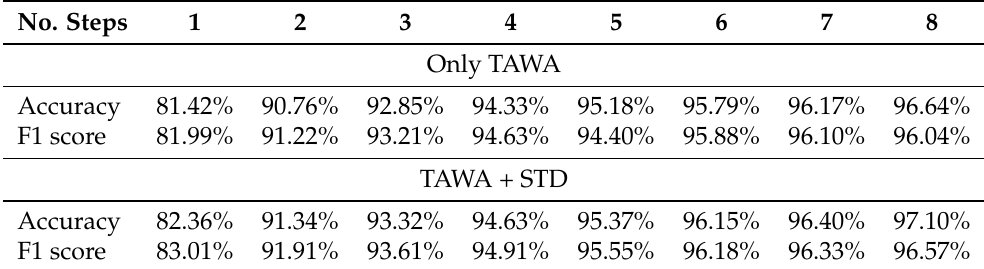
Table 4. Pedestrian identification results with respect to step